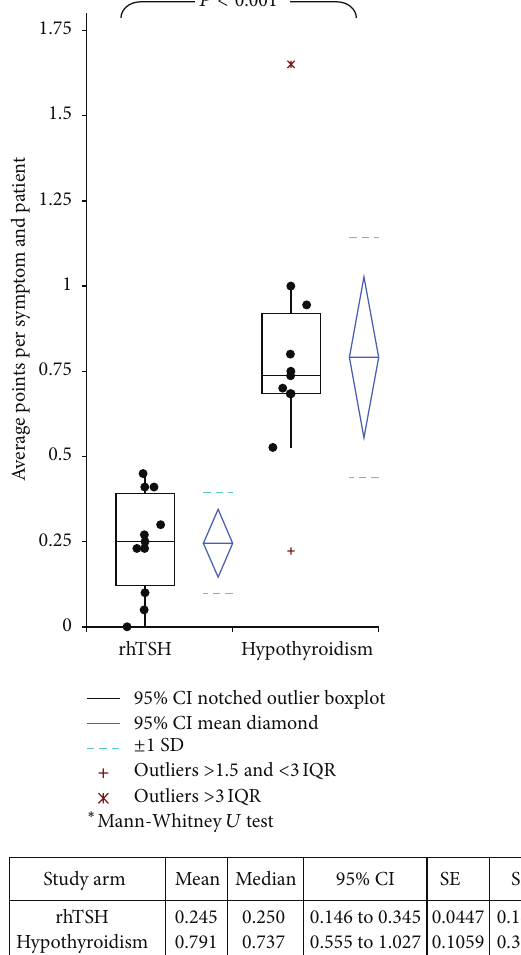
Figure 2: Symptoms of hypothyroidism. Comparison of clinical symptoms for rhTSH receivers versus hypothyroidism patients by compari- son of average points per category and patient. RhTSH patients had significantly fewer symptoms in comparison to standard protocol patients ( 𝑃 < 0.0001 , Mann-Whitney U